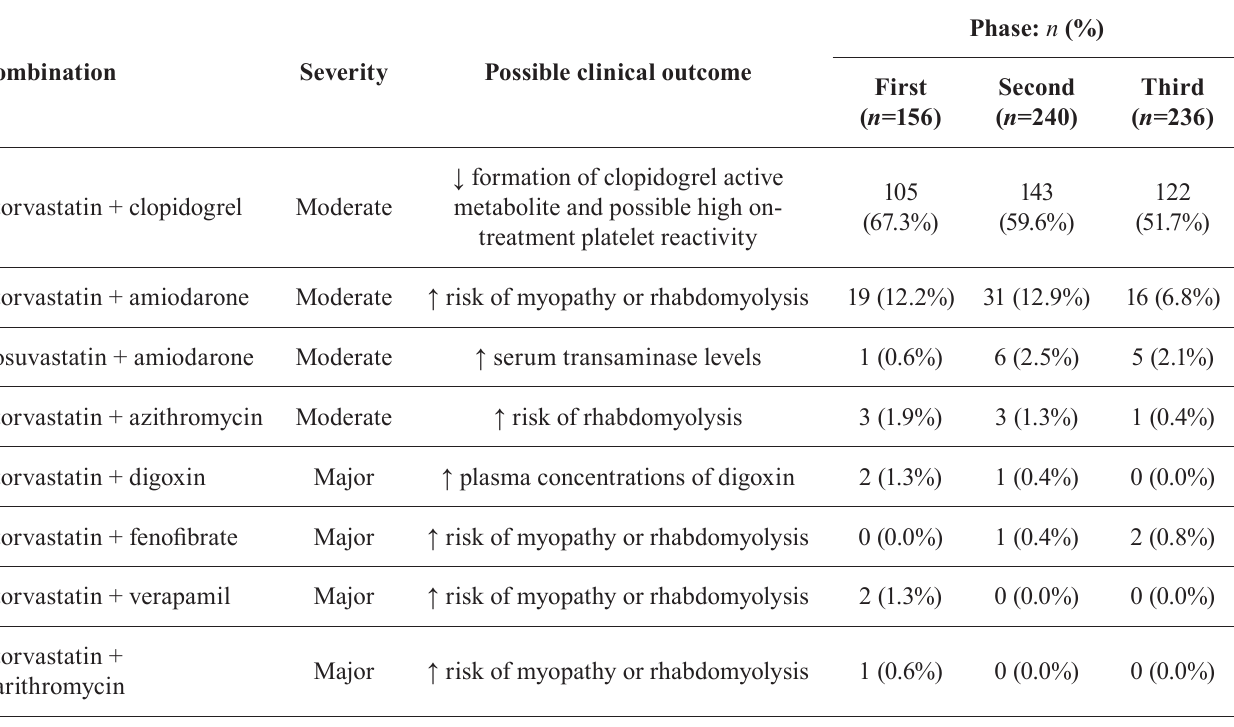
TABLE III – Frequency and description of detected statin potential drug-drug interactions across phases of treatment